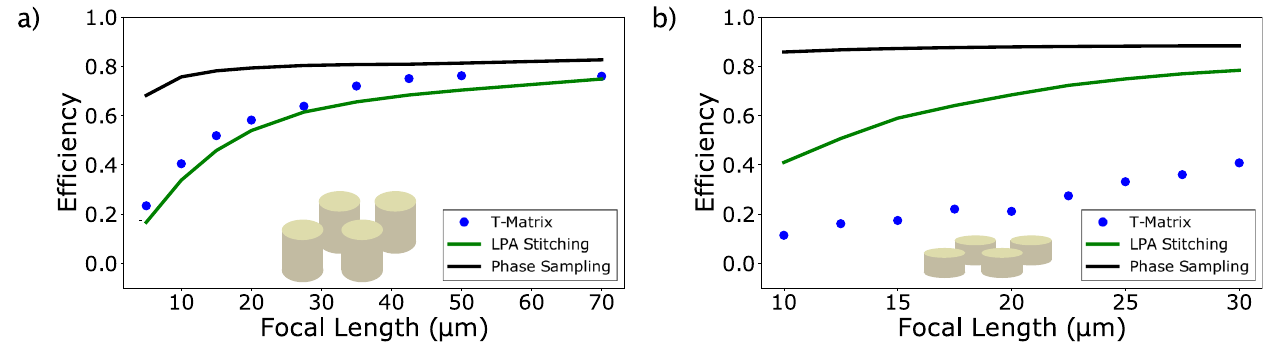
Fig. 3 Comparison of T-matrix method simulations with locally periodic assumption (LPA) simulations. a Ef fi ciency versus focal length for 25 μ m × 25 μ m metasurfaces designed from a library of high aspect-ratio scatterers with a large period (silicon cylinders with height 940 nm, radii range of 50 – 250 nm, lattice period of 1070 nm, and air background; source wavelength of 1550 nm – transmission and phase response shown in Supplementary Fig. 4a, based on scatterer library from Arbabi et al. 61 ) — ef fi ciencies are computed using the T-matrix approach (blue dots), the commonly-used LPA transmission mask phase sampling approach (black curve), and the LPA fi eld-stitching method (green curve). The metalens ef fi ciency is de fi ned as the ratio of the power within a circle of radius 3 × FWHM in the focal plane to the power incident on the metasurface. The T-matrix and LPA-stitching methods agree fairly well here because the scatterers are high aspect-ratio and the lattice constant is large, hence the interactions between neighboring scatterers is negligible. b Ef fi ciency versus focal length for 15 μ m × 15 μ m metasurfaces designed from a library of low aspect-ratio scatterers with a small period (silicon cylinders with height 220 nm, radii range of 175 – 280 nm, lattice period of 666 nm, and background refractive index 1.66; source wavelength of 1340 nm – using scatterer library from Gigli et al. 62 , scatterer transmission and phase response shown in Supplementary Fig. 4b) — ef fi ciencies are computed using the T-matrix approach (blue dots), the commonly-used LPA transmission mask phase sampling approach (black curve), and the LPA fi eld-stitching method (green curve). The metalens ef fi ciency is de fi ned as the ratio of the power within a circle of radius 3 × FWHM in the focal plane to the power incident on the metasurface. The T-matrix and LPA-stitching methods do not agree here because the scatterers are low aspect-ratio and the lattice constant is small, hence the interaction between neighboring scatterers is signi fi